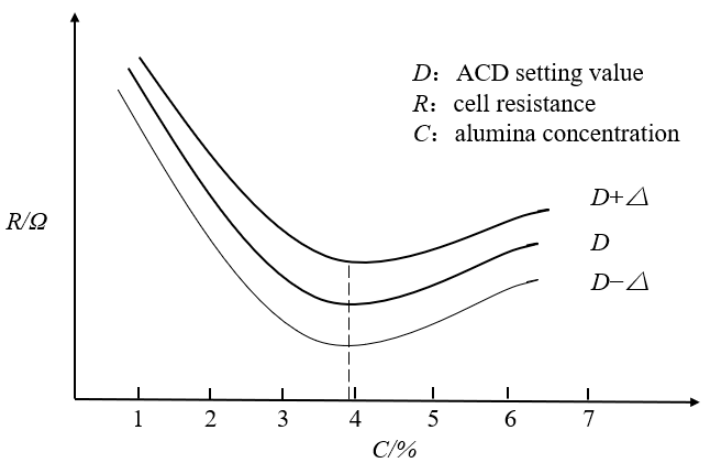
Figure 2. Qualitative relation diagram of cell resistance, alumina concentration and ACD.